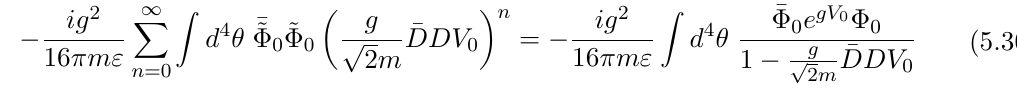
To extract the UV divergence we set all the external momenta to zero, i.e., Ω and ~p = ~p = · · · = 0 . The integrals can be the evaluated by performing the integration 1 2 over ω first, and then using dimensional regularization along the remaining spatial